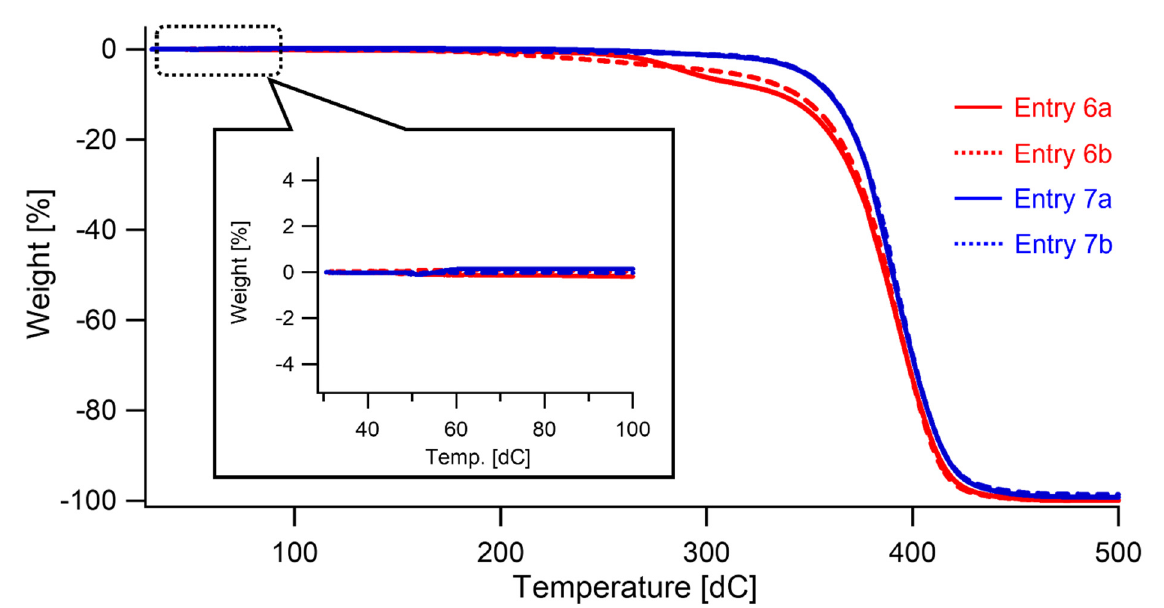
Figure 5. TGA curves corresponding to entries 6a, 6b, 7a, and 7b in Table 3 and 4 to determine the decomposition temperature of PSAs.